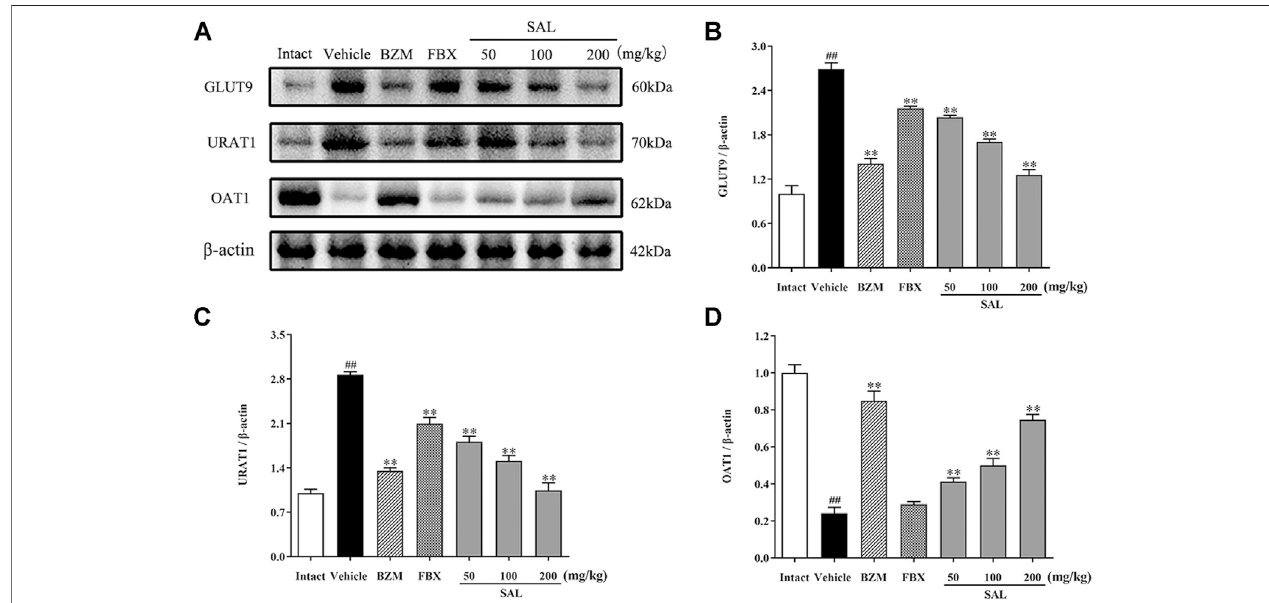
FIGURE10| Effects ofSALon theexpression ofuricacidtransporters. (A) TheexpressionlevelsoftheURAT1,GLUT9,and OAT1;quantitativeresultsofWestern blot analyses for (B) GLUT9; (C) URAT1; (D) OAT1. β -actin was used as a loading control. All data are expressed as mean ± SD ( n (cid:2) 3). ## p < 0.01 vs. the intact group, **p < 0.01 vs. the vehicle